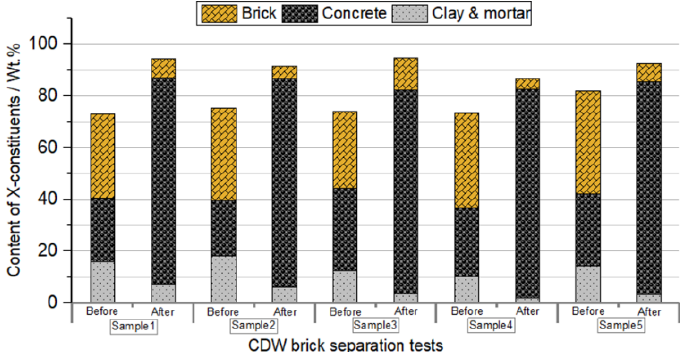
Figure 7. Constituents of the mixed recycled aggregates (MRA) before and after the brick separation test.